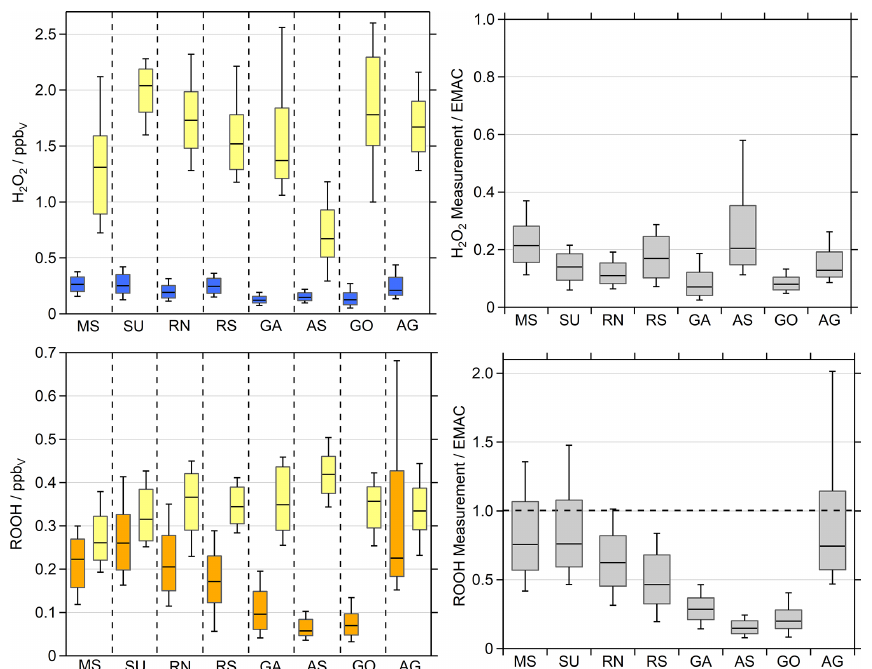
Figure 4. H 2 O 2 (blue) and organic hydroperoxide (ROOH, orange) observations compared to the EMAC simulations (yellow). We used the lowermost model results ( ∼ 30m) for the comparison. The box represents 25% to 75% of the data, and the whiskers are from 10% to 90% with the median as the black line. The right panel shows the ratio between the observations and the